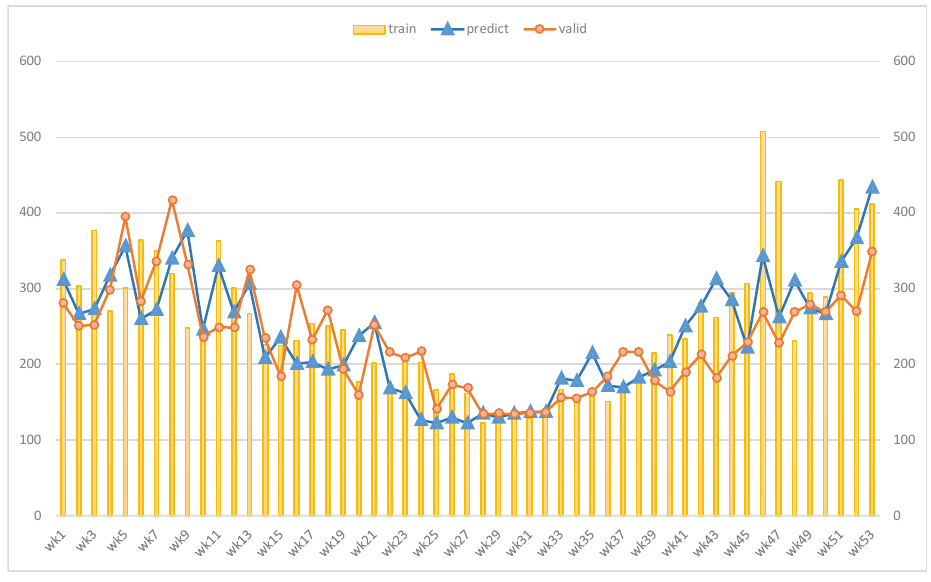
Figure 3. Validation and predicted data. Table 3. Comparison of the models for estimating production capacity.